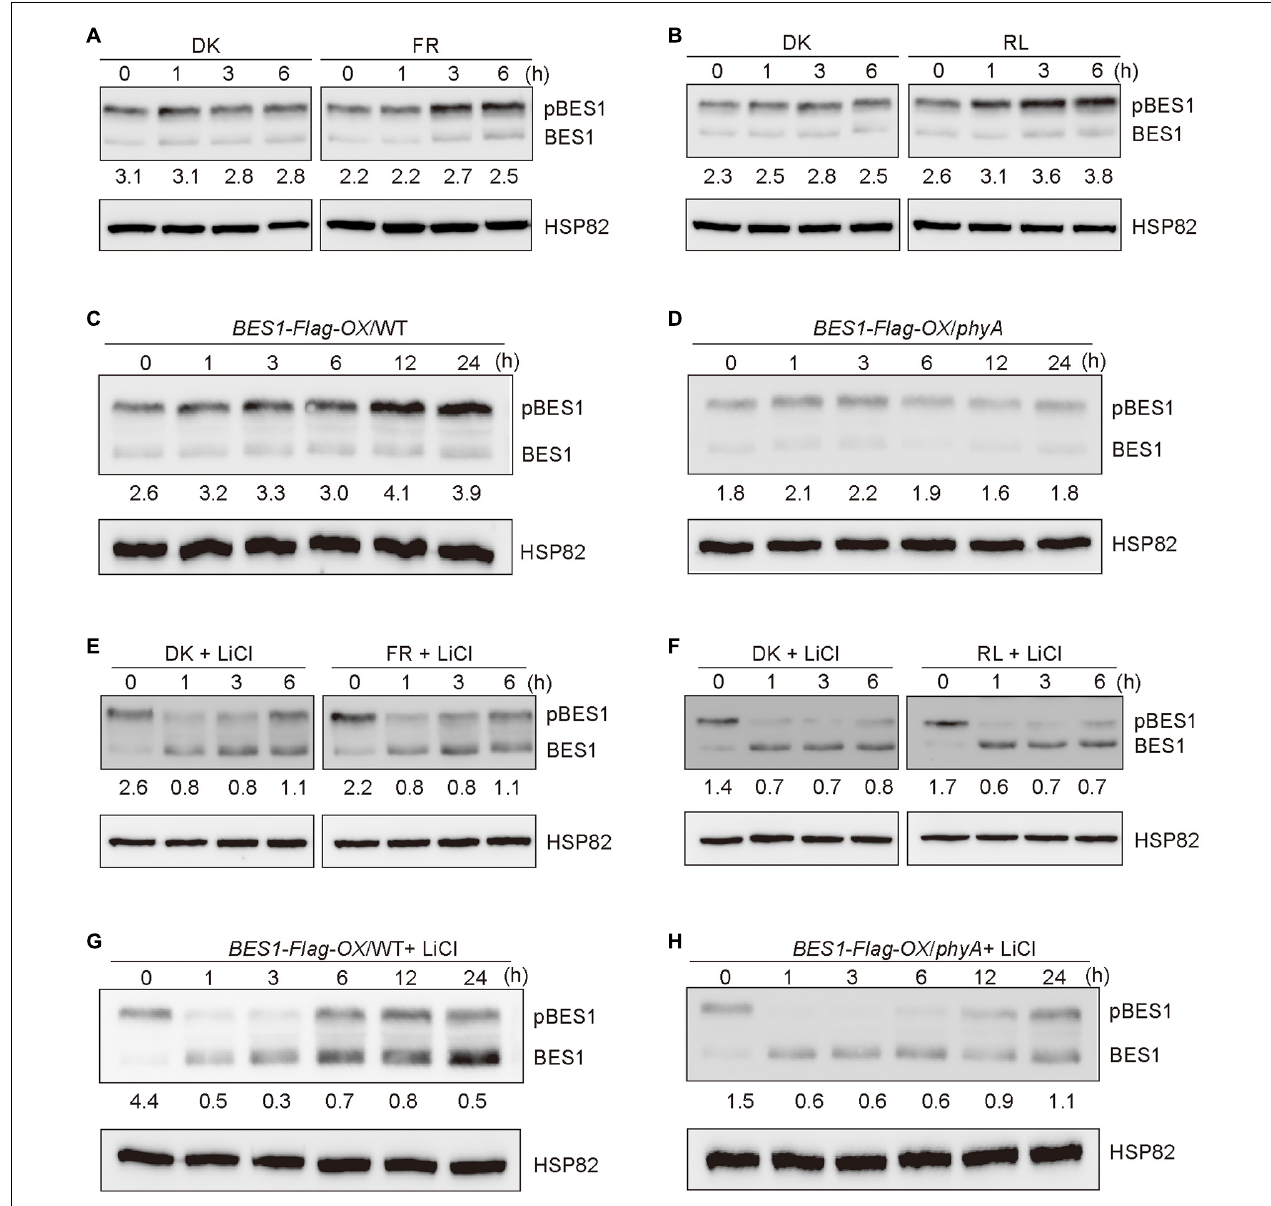
FIGURE 3 | Phytochromes A mediates far-red light promotion of the phosphorylation of BES1 protein. (A,B) Western blot assays showing far-red and red lights promotion of phosphorylation of BES1-Flag protein. BES1-Flag-OX /WT seedlings were grown in darkness for 5 days, and then exposed to far-red light (FR, 10 µ mol/m 2 /s) (A) or red light (R, 50 µ mol/m 2 /s) (B) or adapted in the dark (DK) for the indicated lengths of time. In the Figure 3 , pBES1 and BES1 denote the phosphorylated and dephosphorylated BES1, respectively. The ratio of phosphorylated to dephosphorylated was quantified using Image J and shown below each lane. (C,D) Western blot assays showing that phyA mediates far-red light promotion of phosphorylation of BES1-Flag protein. BES1-Flag-OX /WT (C) and BES1-Flag-OX/phyA (D) seedlings were grown in darkness for 5 days, and then exposed to the far-red light (10 µ mol/m 2 /s) for the indicated lengths of time. (E,F) Western blot assays showing the effects of BIN2 on far-red and red lights promotion of the phosphorylation of BES1-Flag protein. BES1-Flag-OX /WT seedlings were grown on MS plates in darkness for 5 days, and then treated with 10 mM LiCl and exposed to far-red light (10 µ mol/m 2 /s) (E) or red light (50 µ mol/m 2 /s) (F) or adapted in the dark for the indicated lengths of time. (G,H) Western blot assays showing the effects of BIN2 on phyA-mediated far-red light promotion of the phosphorylation of BES1-Flag protein. BES1-Flag-OX /WT (G) and BES1-Flag-OX/phyA (H) seedlings were grown in darkness for 5 days, and then treated with 10 mM LiCl and exposed to far-red light (10 µ mol/m 2 /s) for the indicated lengths of time.